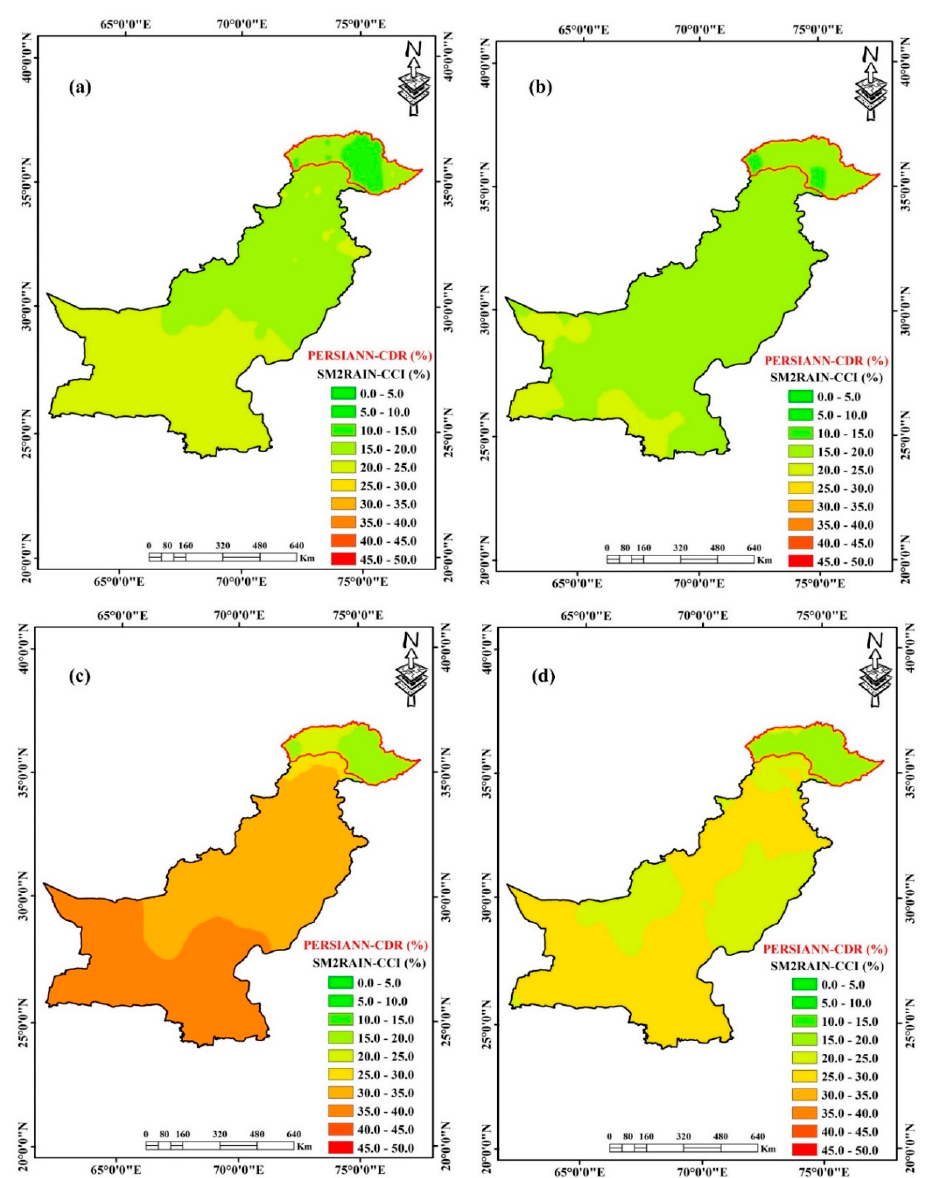
Figure 7. Spatial distribution of average Precipitation Estimates from Remotely Sensed Information Using Artificial Neural Networks-Climate Data Record (PERSIANN-CDR) and SM2RAIN-CCI seasonal weights, across Pakistan from 2007 to 2018. ( a ) Pre-monsoon; ( b ) Monsoon; ( c ) Post-monsoon; ( d ) Winter. Figure 6 represents the seasonal distribution of SM2RAIN-ASCAT weights across